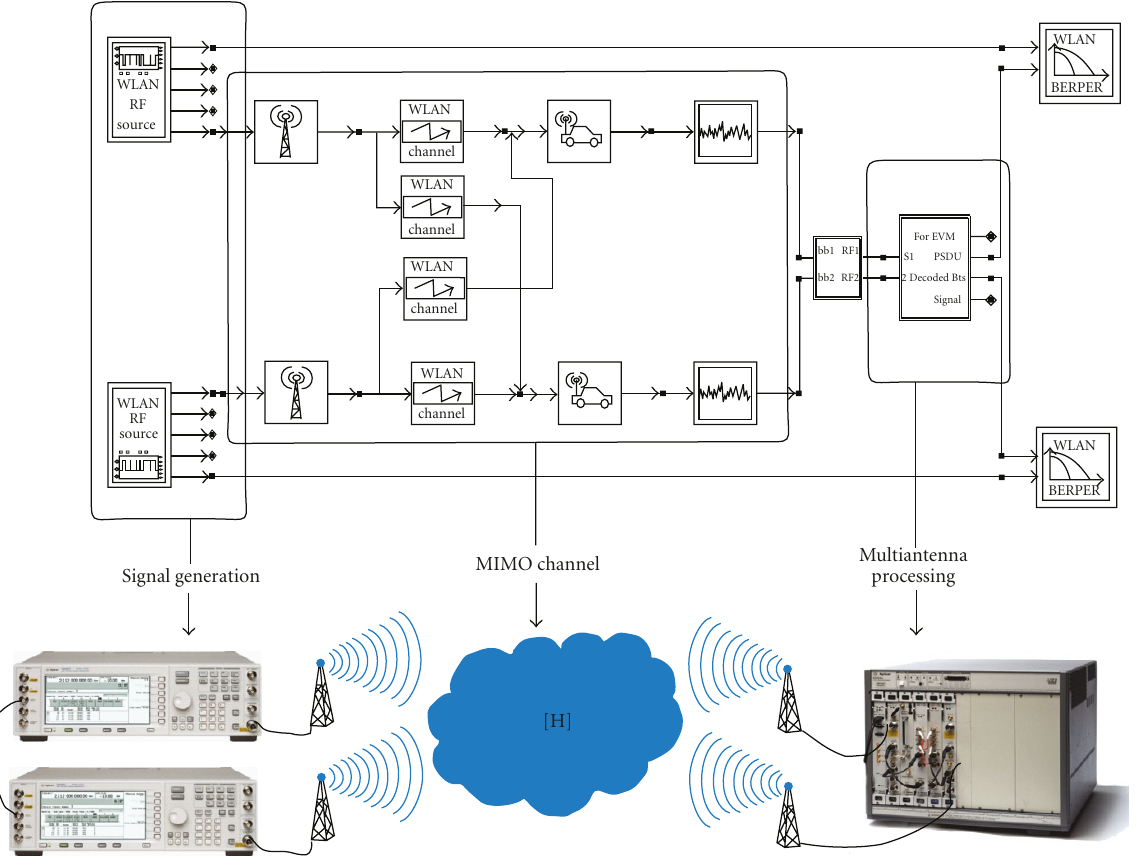
Figure 4: 2 × 2 MIMO radio platform with connected solution with ADS